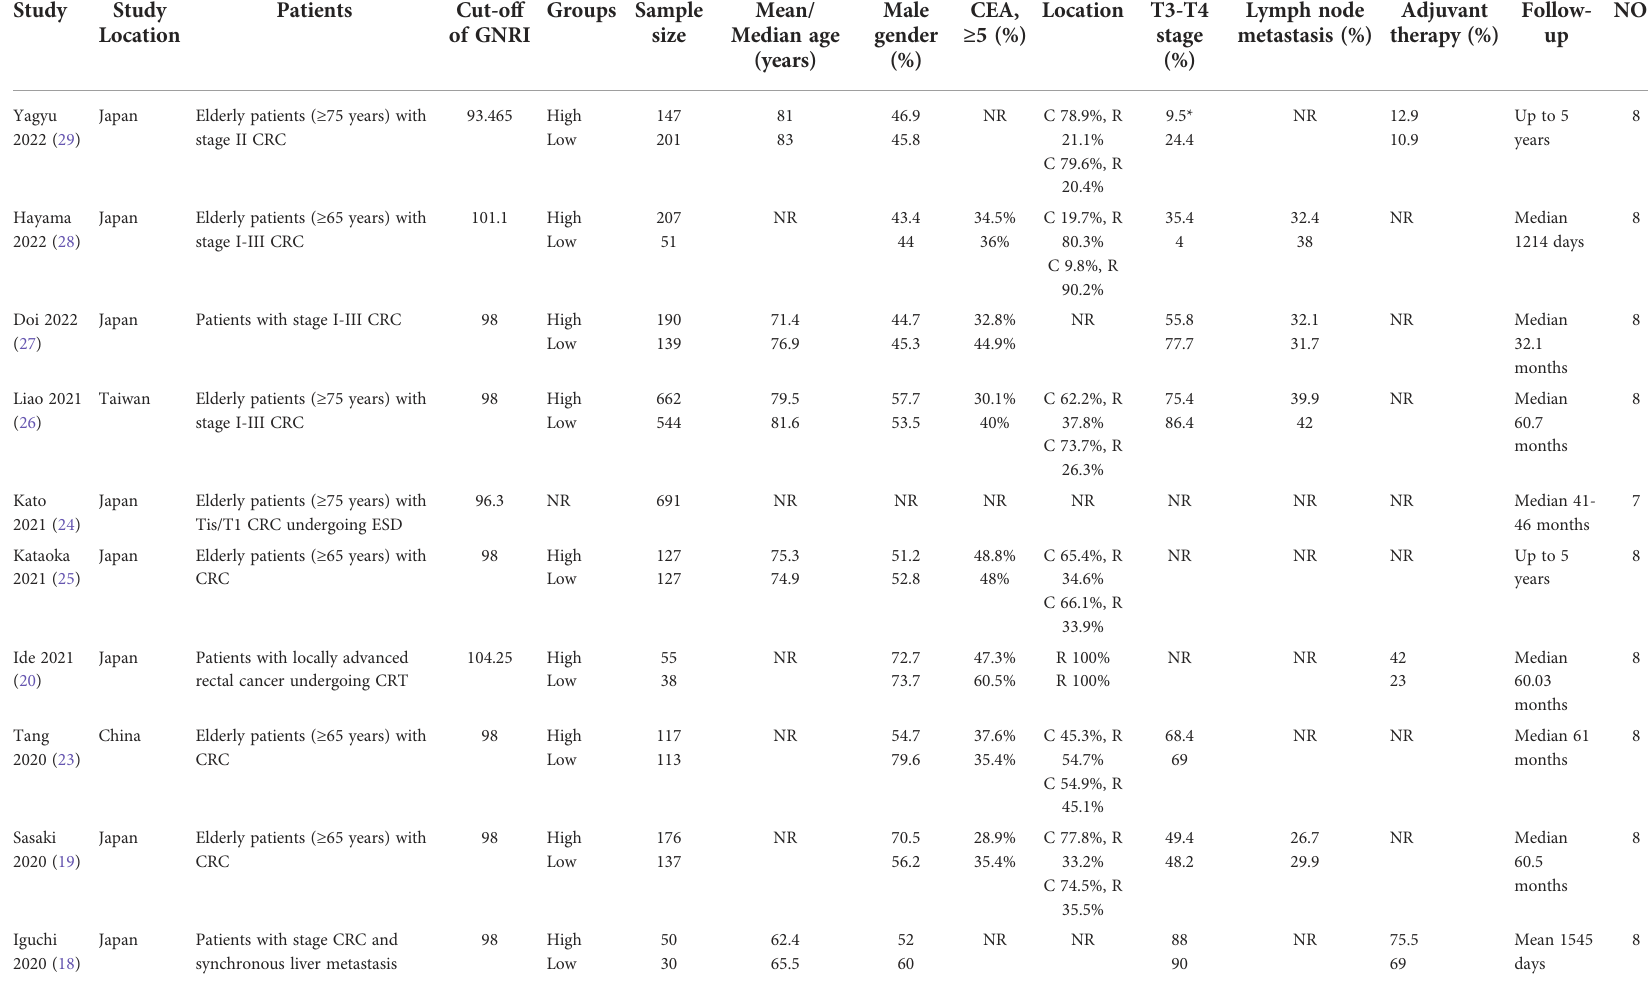
TABLE 1 Details of included